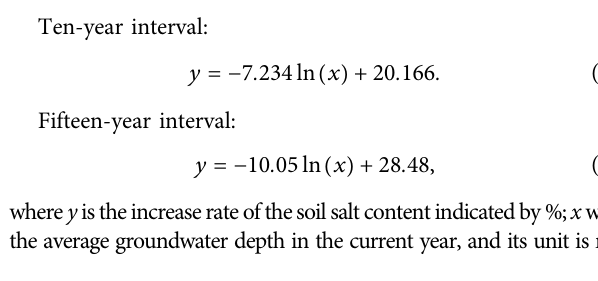
Frontiers in Earth Science |